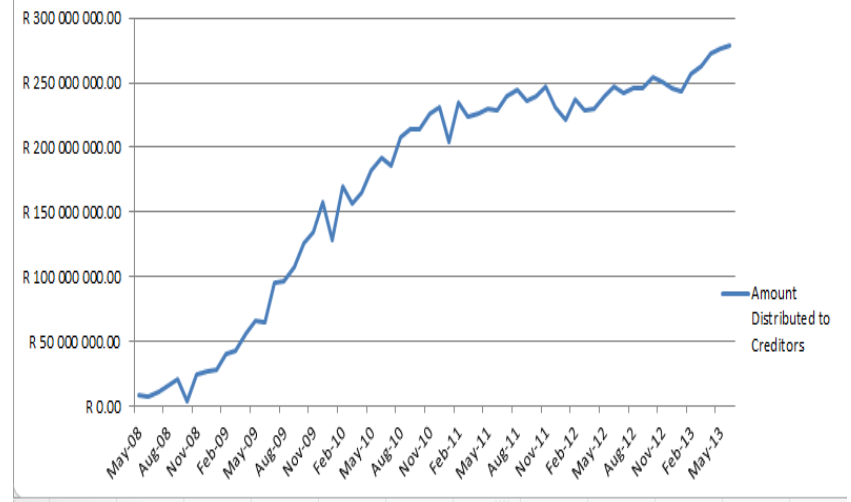
FIGURE 2: Payments distributed by PDAs to creditors from 2008 to 2013 Source: Adapted from NCR